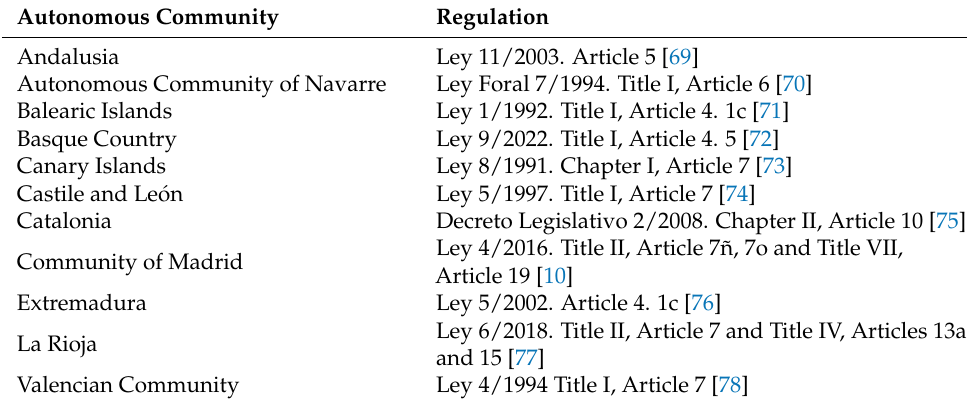
Table 4. Articles of the Animal Protection Code that mention filming by autonomous communities